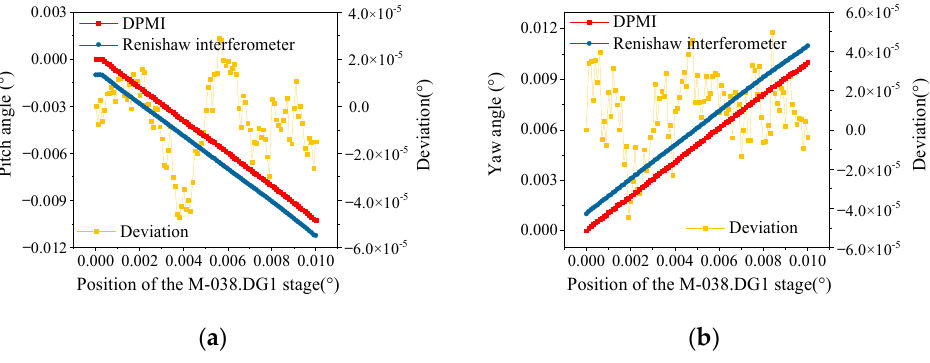
Figure 5. Comparison of experimental results of angle measurement: ( a ) pitch angle; the blue dots are shifted by 0.001° to make the plots visible; ( b ) yaw angle; the blue dots are shifted by 0.001° to make the plots visible.